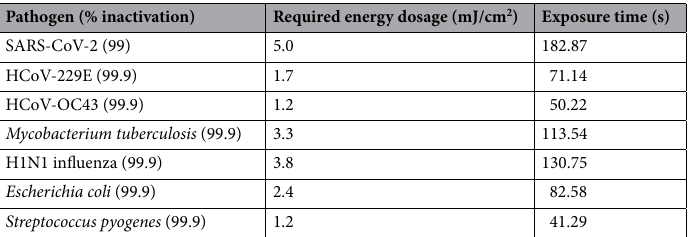
Table 2. Required energy dosages for inactivation and calculated exposure time values for seven common pathogens 15–17,24